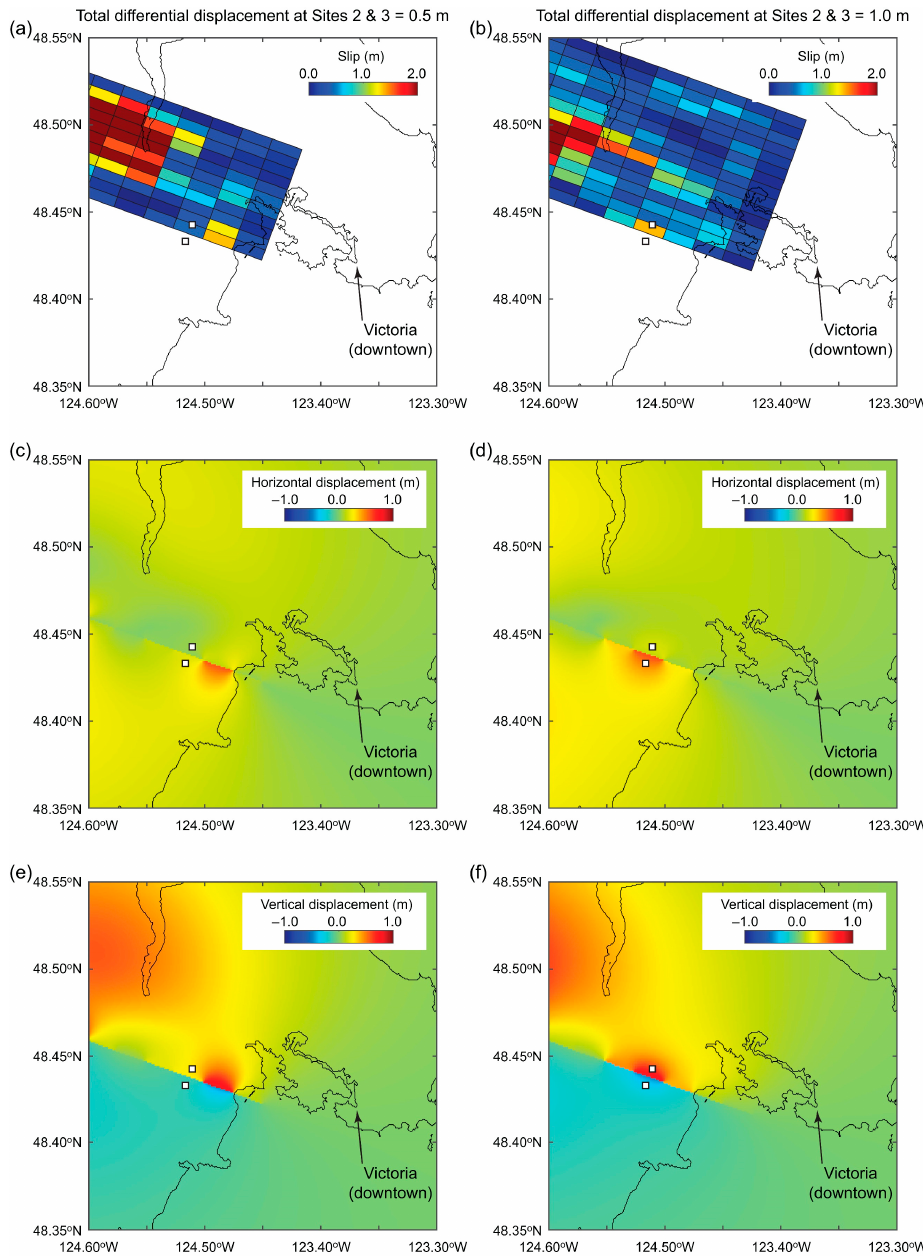
Figure 13. Local views of earthquake slip distribution ( a , b ), horizontal displacement ( c , d ), and